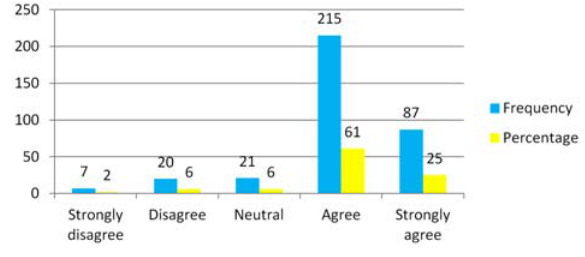
Fig. 2. Entrepreneurial attitude of the respondents